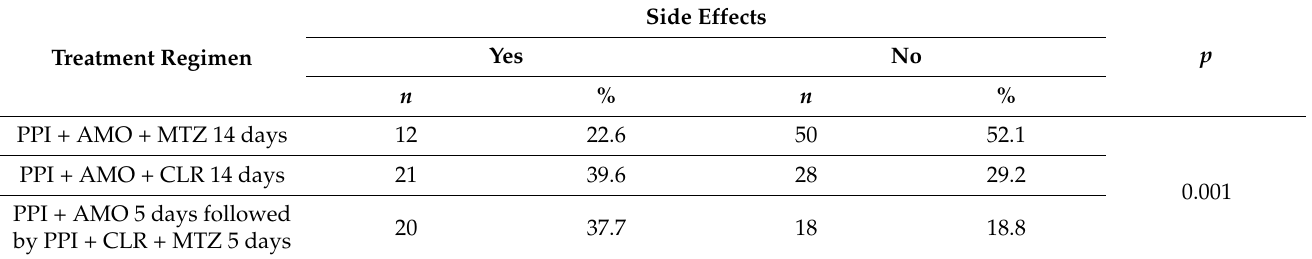
Table 4. Side effects depending on the therapeutic scheme.